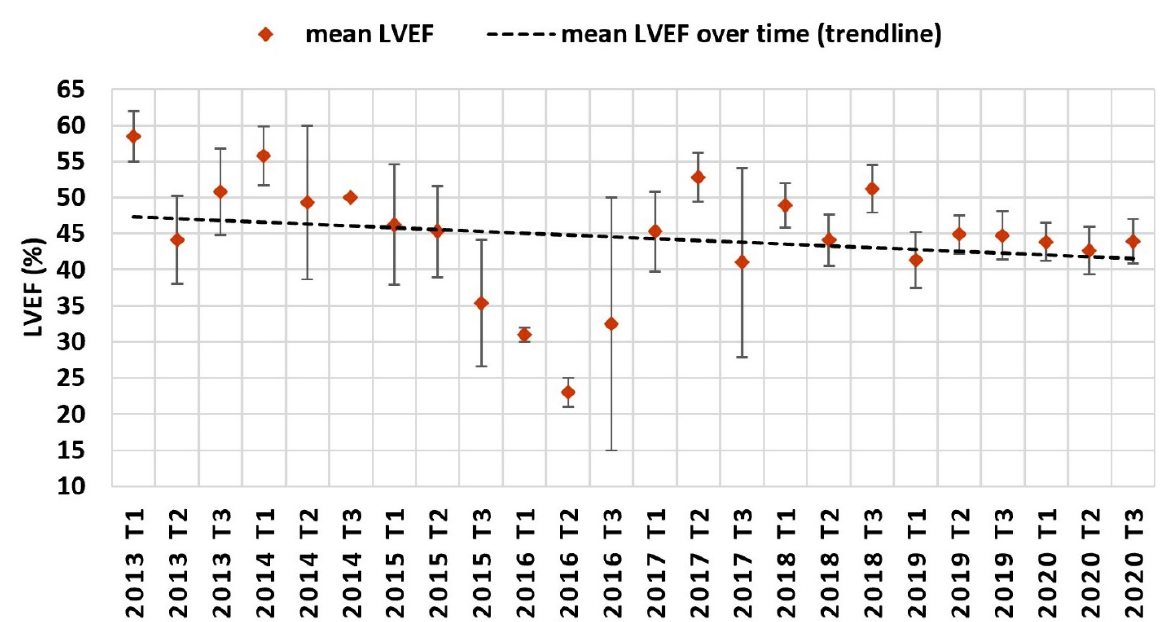
Figure 5. Cardiovascular risk factors over time. The relative number of patients diagnosed with arterial hypertension ( A ), chronic kidney disease ( B ), diabetes mellitus ( C ), and LVEF < 50% ( D ) prior to transvenous lead extraction over time. Data is demonstrated for every four-month period including trendline analysis. LVEF: left ventricular ejection fraction.